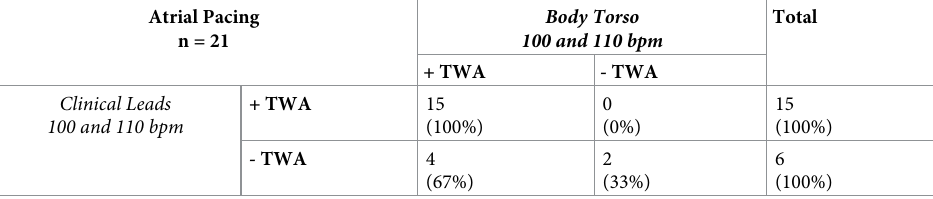
Table 2. Effect of lead configuration on clinically +TWA during atrial